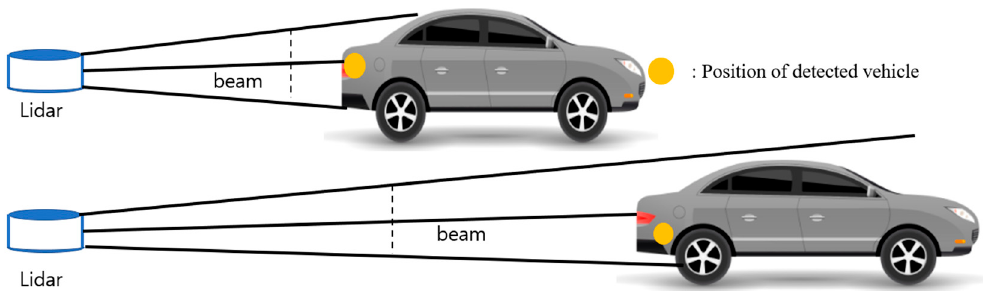
Figure 2. Estimated position of the forward vehicle with a lidar sensor.